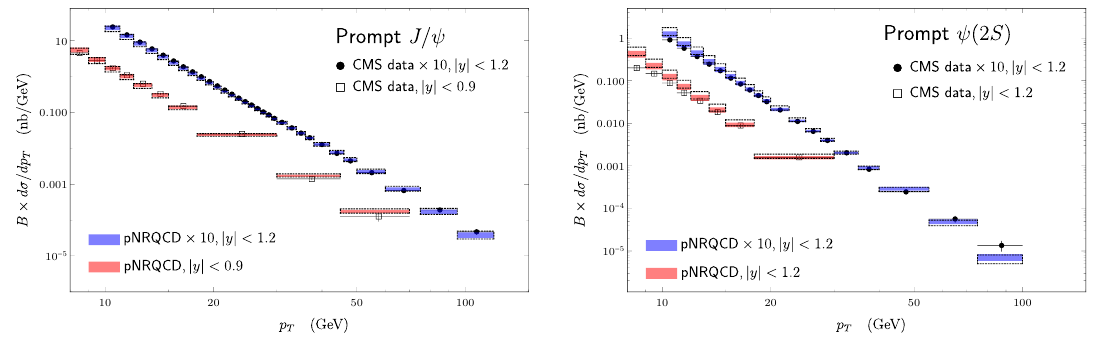
Figure 9 . Production cross section of prompt J/ψ and ψ (2 S ) at the LHC center of mass energy √ s = 7 TeV compared to CMS data [69, 72]; B is the dimuon branching fraction. Results from the LDMEs given in table 3 are shown as dotted outlined bands.